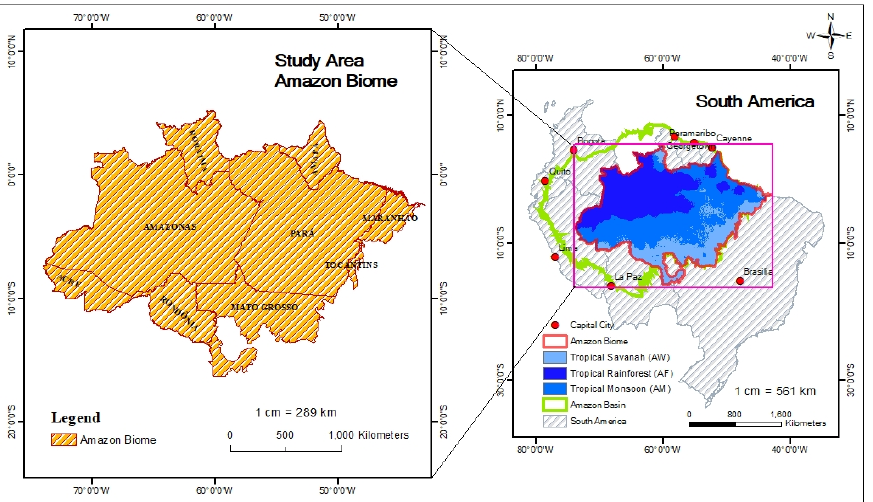
Figure 1. Location of the study